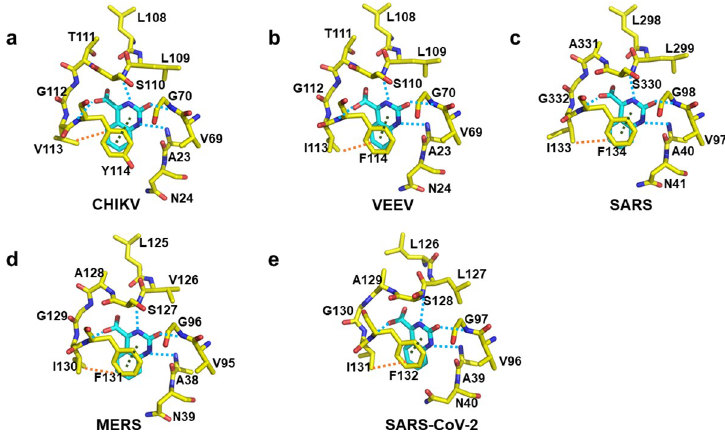
Fig 7. The structure of CHIKV nsP3MD-SRI-43750 and the docking results of SRI-43750 bound to macrodomains from VEEV, SARS, MERS and SARS-CoV-2. a) Co-crystal structure of CHIKV nsPMD-SRI-43750 (PDB ID: 6W8M). b) Docking model of SRI-43750 in the macrodomain of VEEV (PDB ID: 3GQO) [29]. c) Docking result of SRI-43750 in the macrodomain of SARS (PDB ID: 2FAV) [53]. d) Docking model of SRI-43750 in the macrodomain of MERS (PDB ID: 5HOL) [54]. e) Docking model of SRI-43750 in the macrodomain of SARS-CoV-2 (PDB ID: 6W02) [53]. The conserved residues interacting with SRI-43750 in the macrodomain structures of alphaviruses and coronaviruses are highlighted in yellow sticks and SRI-43750 shown in cyan sticks in all structures. Hydrogen bonds, hydrophobic contacts, and π - π stacking are indicated by cyan, orange, and dark green dashed lines